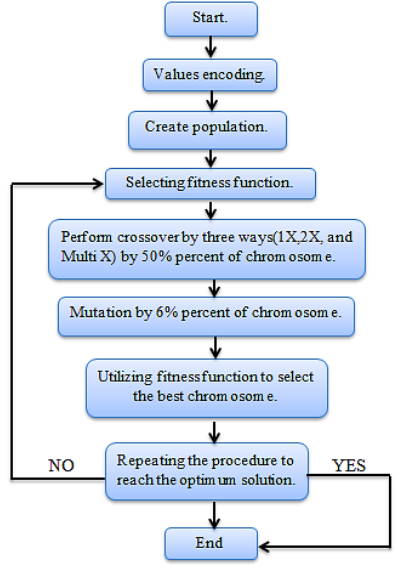
Figure 6: Flow chart of a simple genetic algorithm